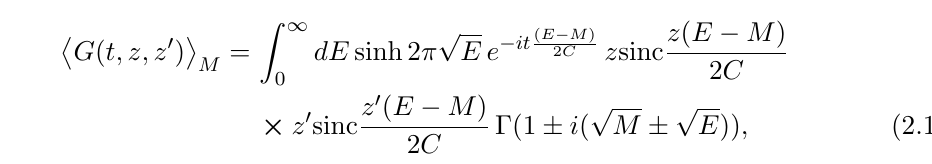
Figure 3 . Two scalar operators φ at ( u, v ) and ( u are encountered on the four lines of lightcone separated events: two direct lines, φ ( u, v ) φ ( u (cid:31) , v (cid:31) ) (cid:30) (cid:31) and two indirect lines obtained by reflection on the holographic